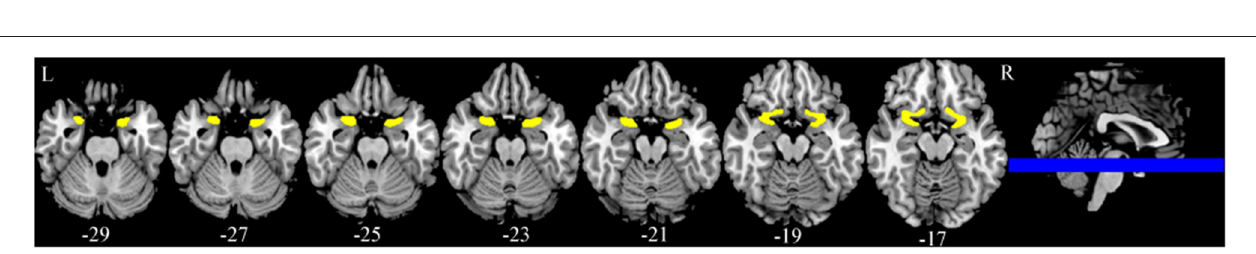
FIGURE 2 | Bilateral primary olfactory cortex (POC). The central MNI coordinates are ( − 24, 0, − 17) and (24, 0, − 17).